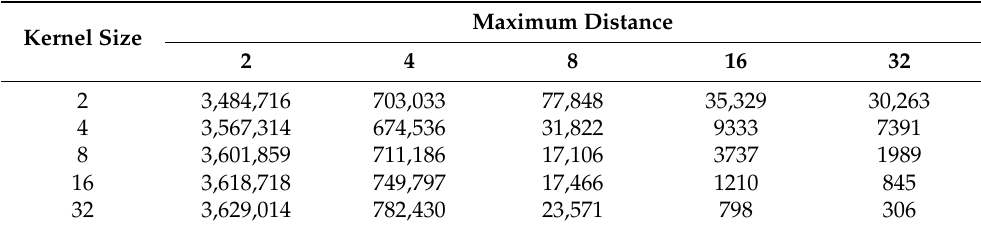
Table 2. Number of objects based on different segmentation